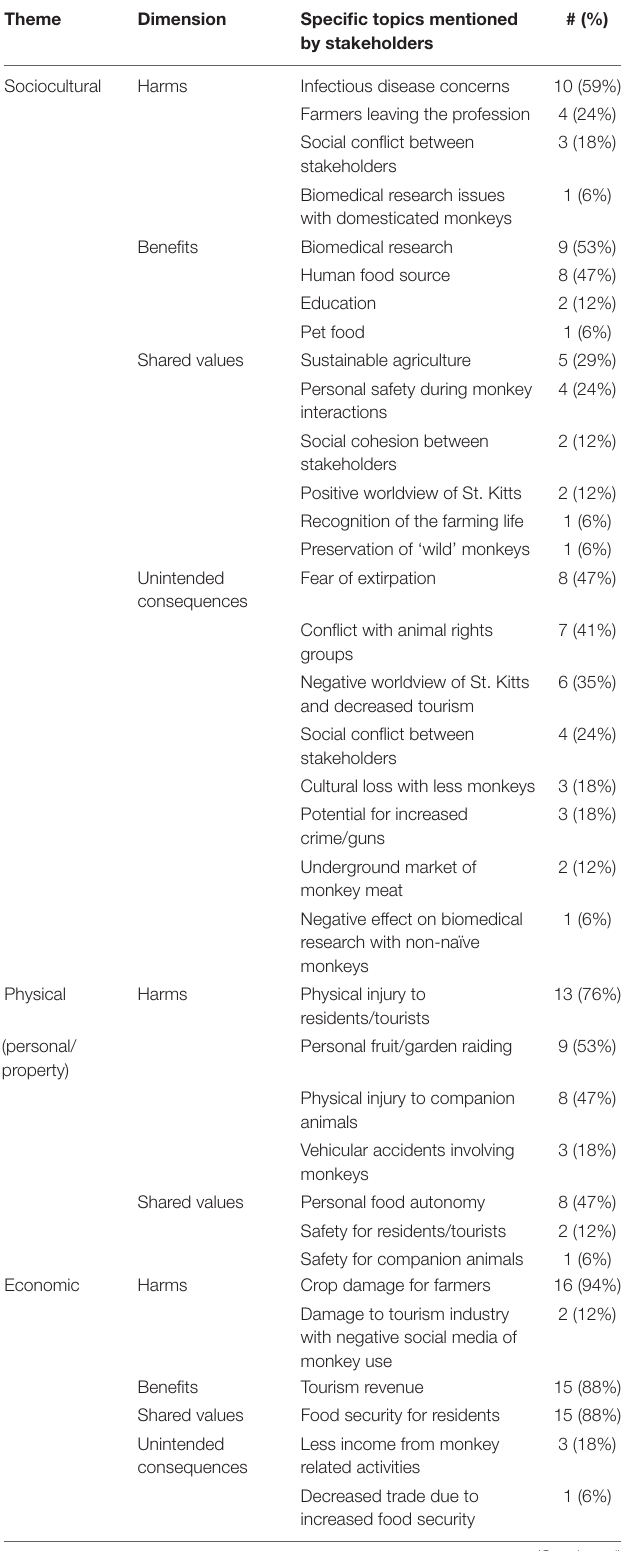
TABLE 3 | Thematic clustering of stakeholder perceived harms, benefits, shared values and unintended consequences of the St. Kitts’ “monkey problem.”